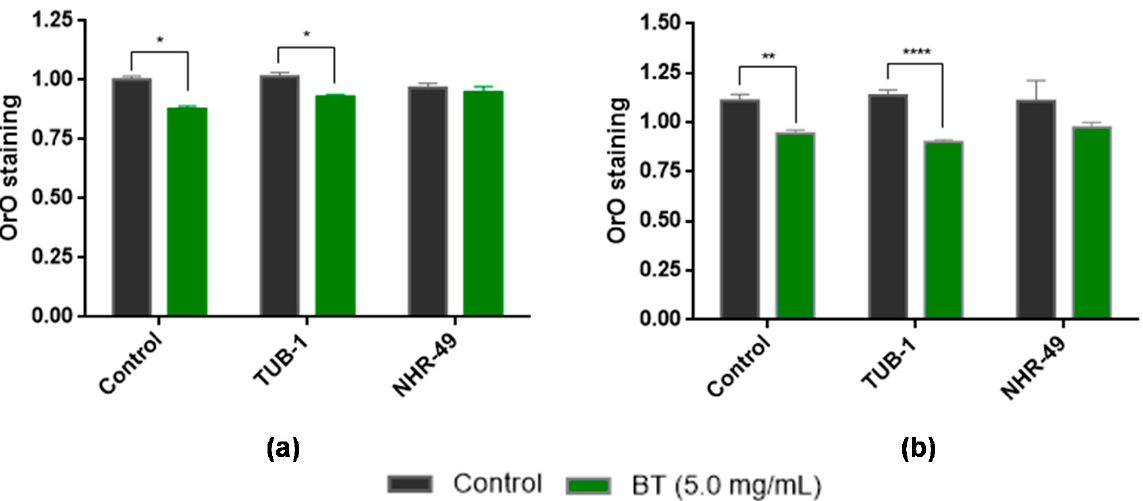
Figure 7. Contribution of TUB-1 and NHR-49 transcription factors to lipid accumulation in animals treated with Baccharis trimera leaf extract (BT) at 5.0 mg/mL. Wild-type animals (N2) in L1 stage were treated with BT for 48 h with low glucose ( a ) and high glucose ( b ). **** p < 0.0001, ** p < 0.01 and * p < 0.05, being statistically significant in relation to the control, according to ANOVA, followed by the